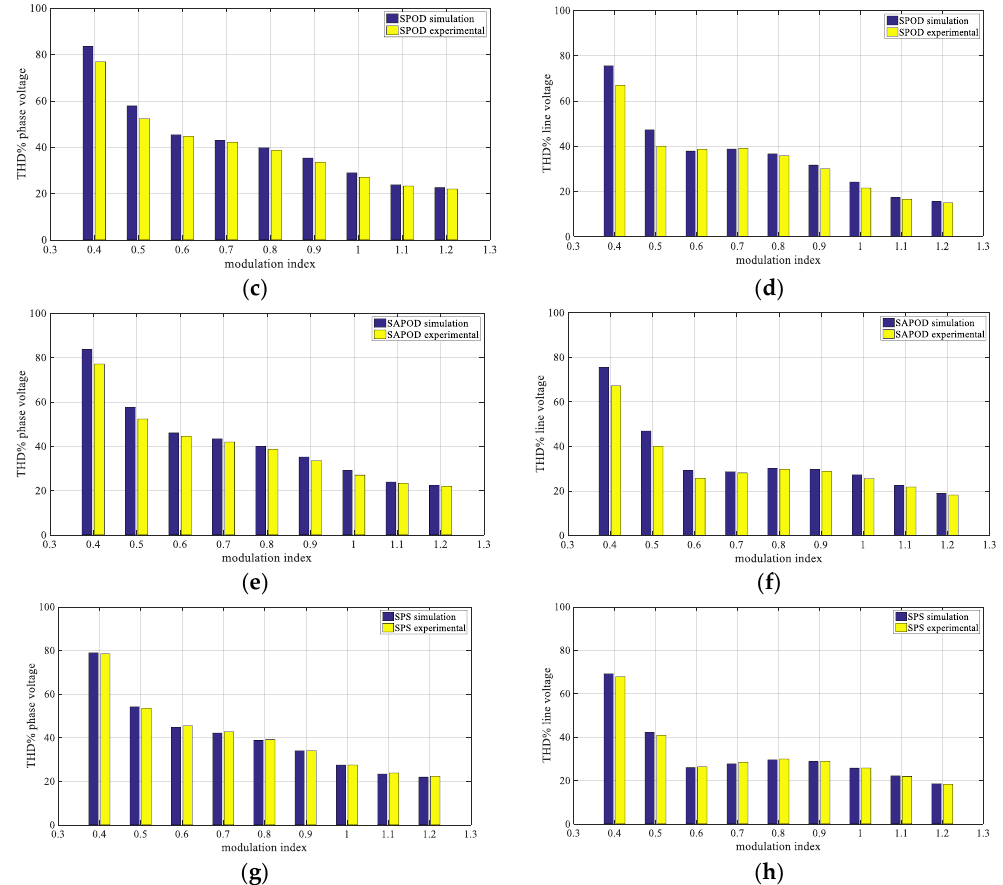
Figure 9. Comparison between the simulated (blue) and the experimental (yellow) THD% values. ( a ) Phase Voltage-SPD; ( b ) Line Voltage-SPD; ( c ) Phase Voltage-SPOD; ( d ) Line Voltage-SPOD; ( e ) Phase Voltage-SAPOD; ( f ) Line Voltage-SAPOD; ( g ) Phase Voltage-SPS; ( h ) Line Voltage-SPS.